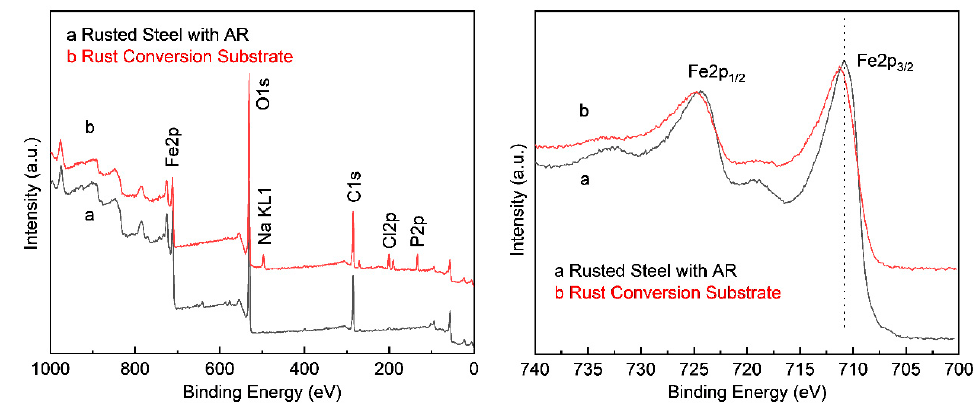
Figure 9. XPS spectrum and specific element peaks of ( a ) Rusted Steel with AR and ( b ) Rust Conversion Substrate.